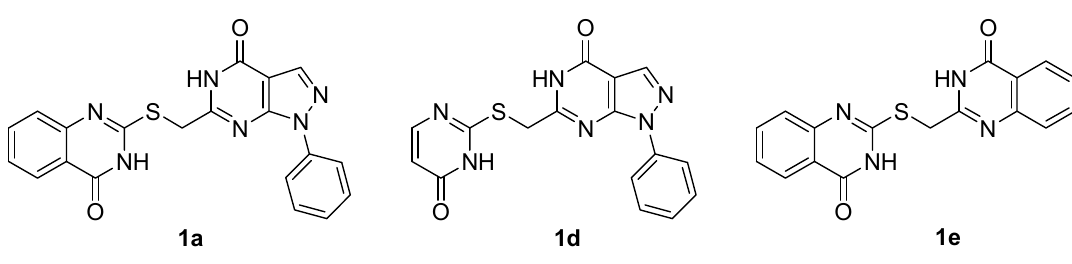
Figure 2. The structure of compound 1a and its analogs 1d and 1e